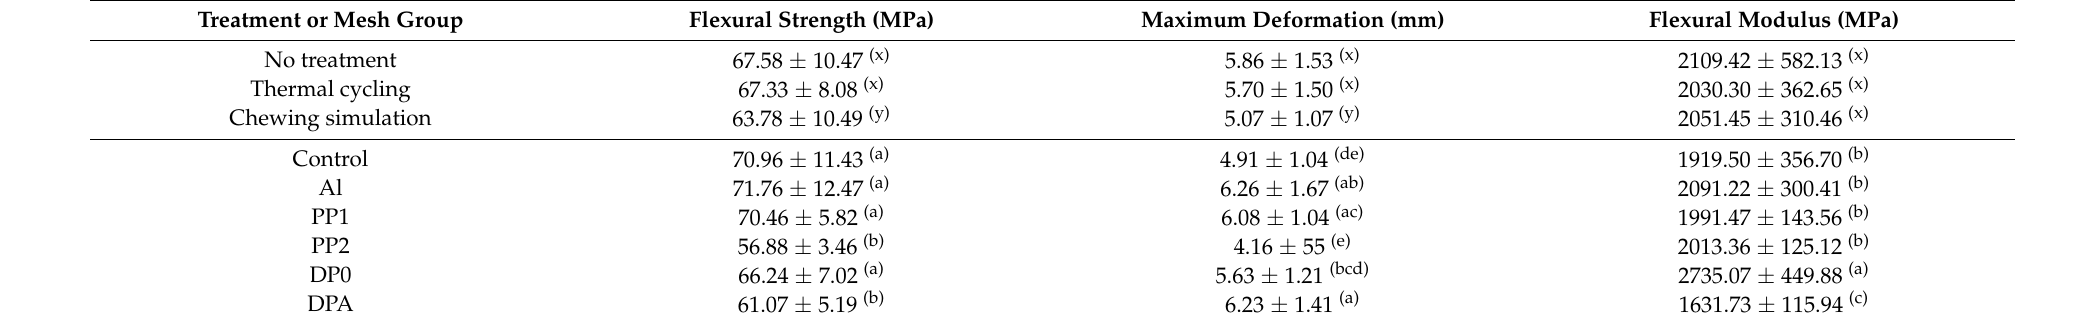
Table 3. Mean, standard deviations, and significance of three mechanical properties by comparisons of the three-point bending test results. Treatment or Mesh Group